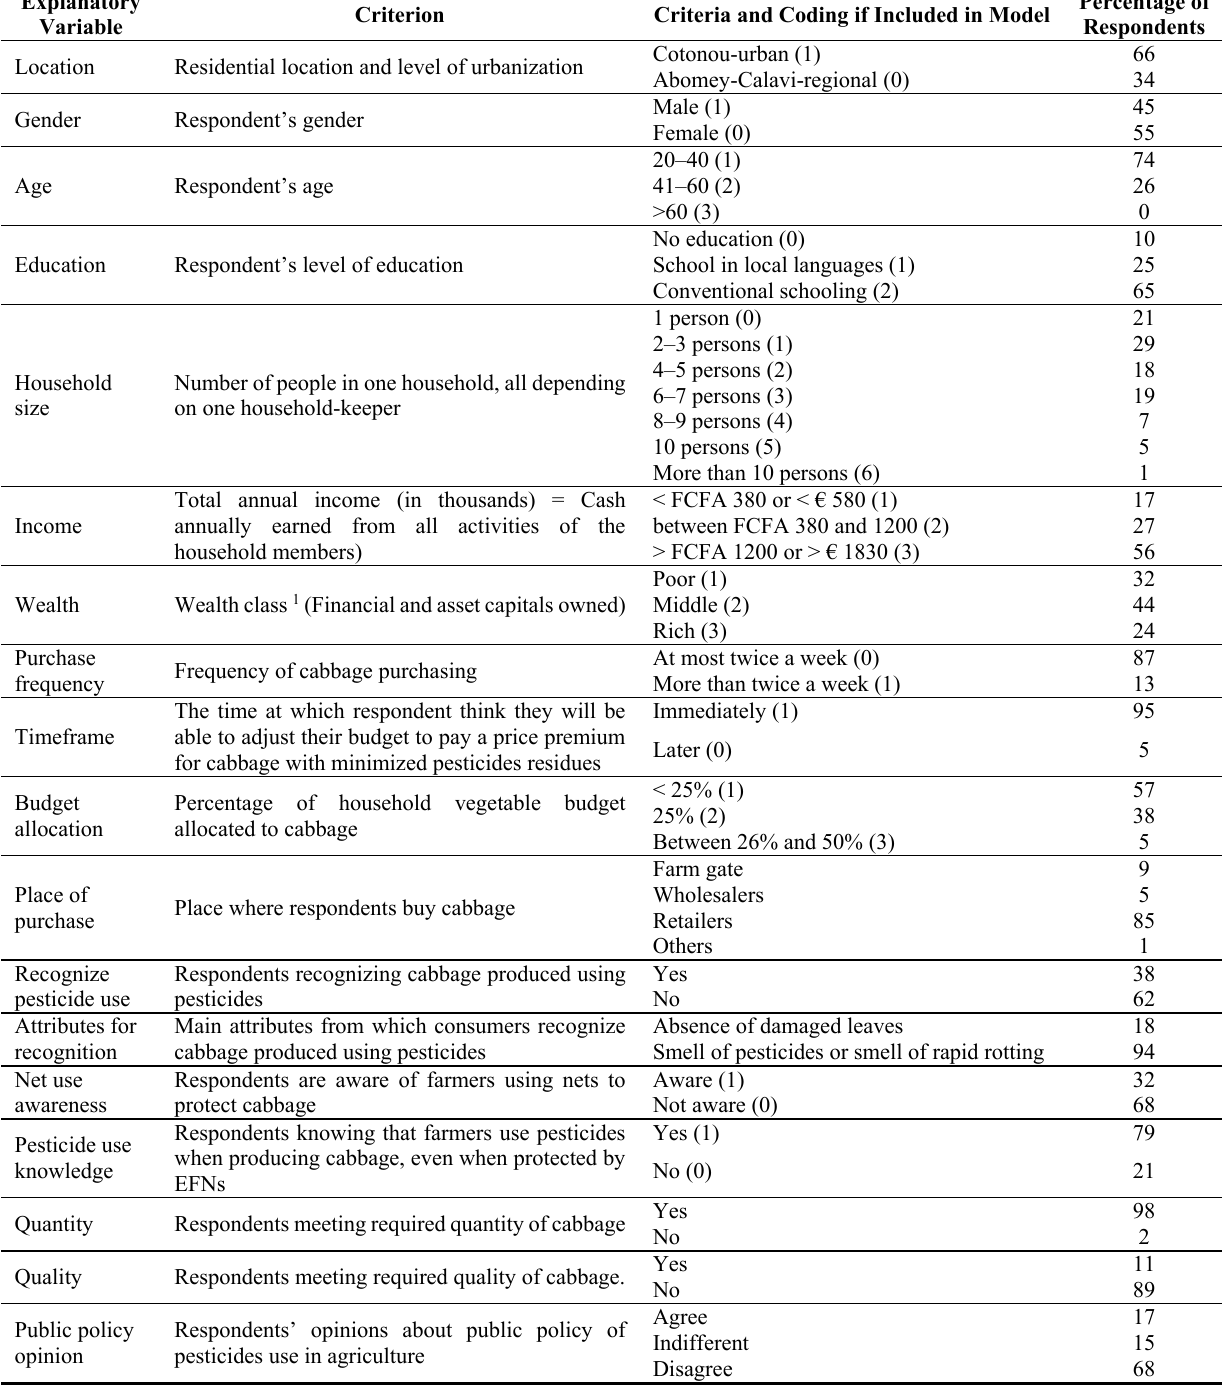
Table 1. Sample description and explanatory model